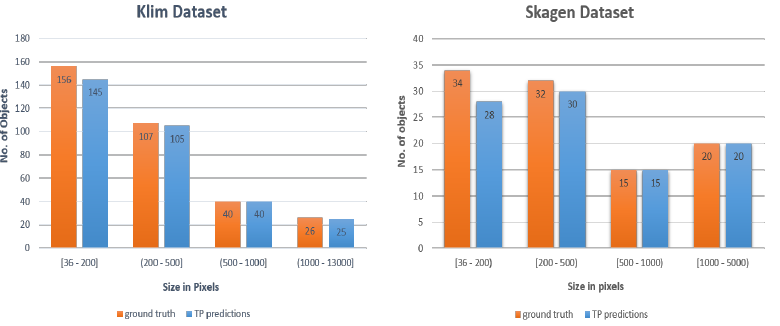
Figure 6. Size and number of ground truth and true detected objects using Model 3 for Klim ( left ) and Skagen ( right ) testing